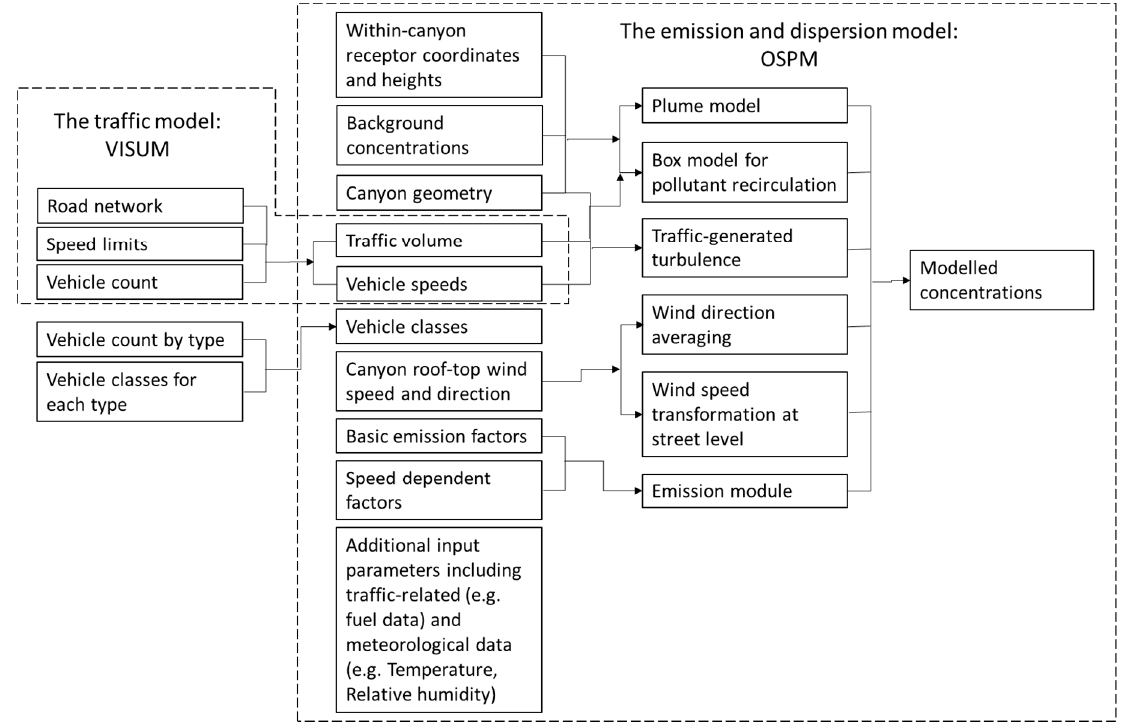
Figure 2. Schematic representation of the principal modules of VISUM & OSPM modelling chain. (Adapted from: Aquilina & Micallef, 2004 [35]).